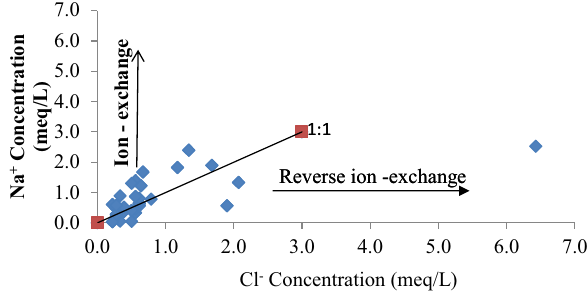
−I ) vs. Ca + Mg (meq L −I ) for Fig. 7 Plot of HCO 3 + SO 4 (meq L groundwater within the Asutifi-North